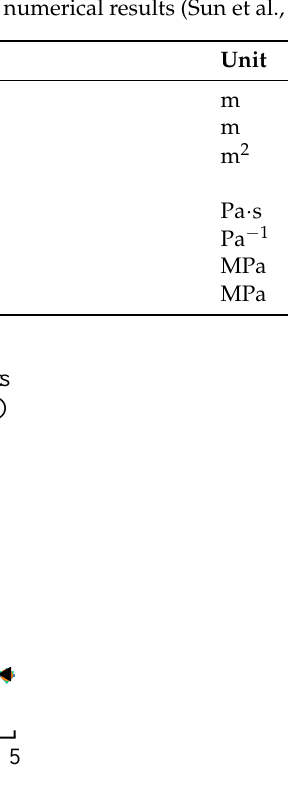
Table 3. Parameters employed in comparison with the numerical results (Sun et al., 2018) [44]. Figure 5. Comparison of the seepage force versus distance from the wellbore wall between the analytical and numerical results (FLAC3D) for various times.